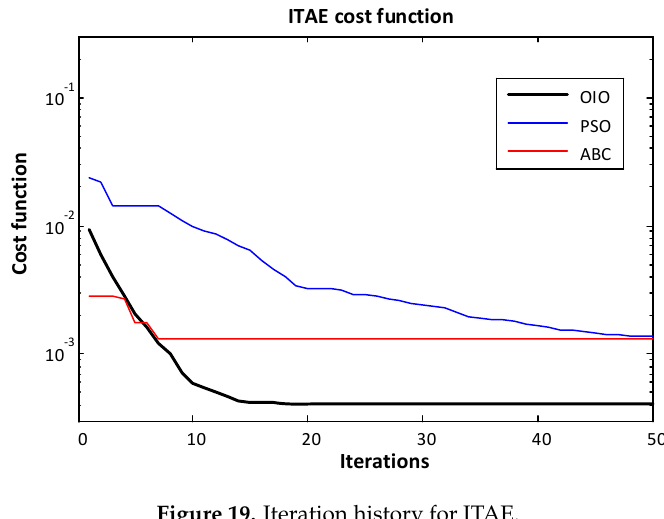
Figure 19. Iteration history for ITAE.